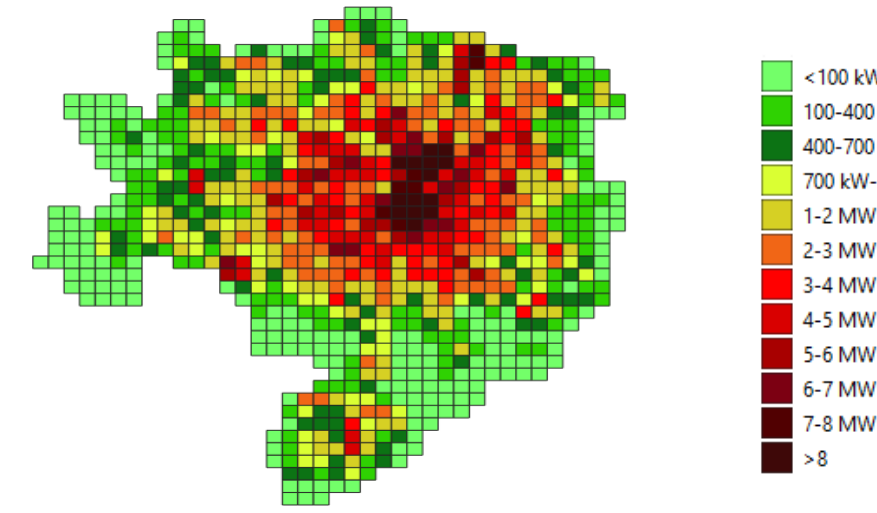
Figure 9. Load map considering the yearly peak power.